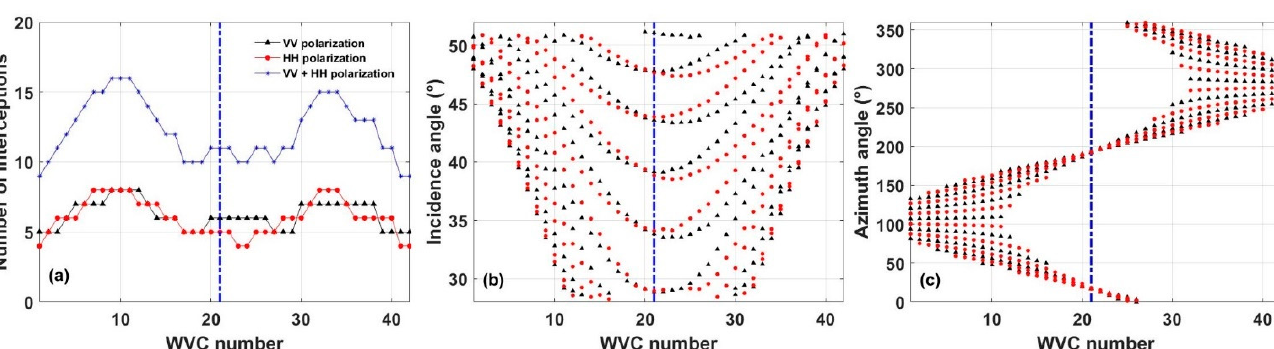
Figure 1. Distribution of CSCAT ( a ) number of interceptions (black triangles for VV polarization, red dots for HH polarization, and blue stars for total observation), ( b ) incidence, and ( c ) azimuth angles versus the cross-track WVC number for a descending row at latitude of ~20 ° , where the black triangle and red dots represent the VV and HH polarization views, respectively.